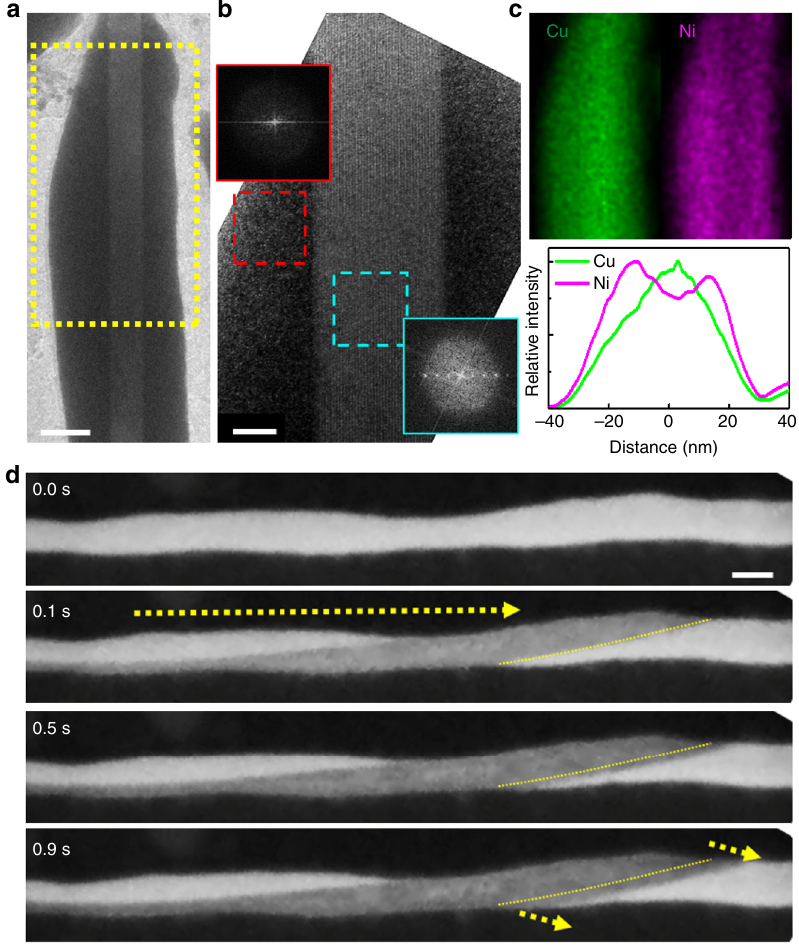
Fig. 5 Observation of partially crystallized nanorods with solution partitioning upon cooling. a , b A 55 nm partially crystallized nanorod ( a ), obtained by a constant cooling rate of 10 °Cs − 1 . A crystalline core, of which the width and length dimensions are 20 nm and over 330 nm, is shown to be single crystalline surrounded by an amorphous shell ( b ). Scale bars are 25 and 6 nm, respectively in a and b . The Fourier transformed images (diffractograms) obtained from the core crystalline region (cyan dashed square) and the amorphous shell (red dashed square) con fi rm the single crystalline and the amorphous nature, respectively. c Cu and Ni maps obtained from the yellow dashed region in a are shown with their relative intensity pro fi les. The crystallized core is Cu-rich and simultaneously Ni-poor. d Snapshot DF TEM images of a 25 nm nanorod from an in situ movie (Supplementary Movie 5). The growth of the single crystalline core during a constant cooling (50 °Cs − 1 ) is captured by tracing the expansion of the crystalline growth front, re fl ected as the change of imaging contrast (yellow dashed lines). Scale bar = 30